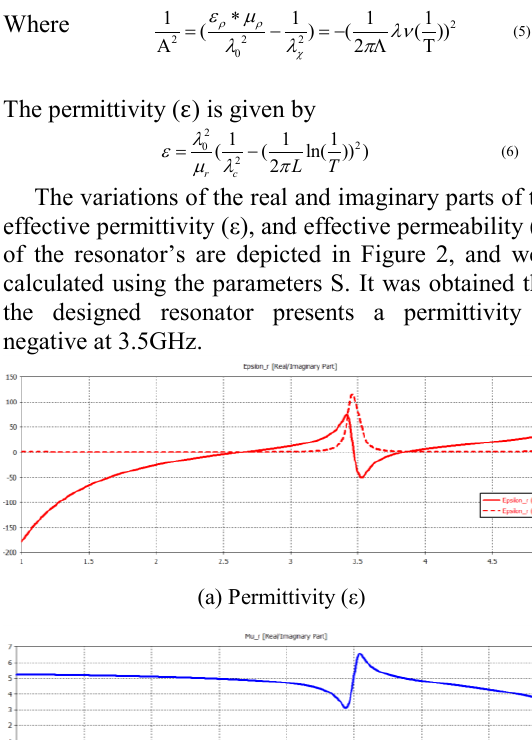
Table 1. The optimized parameters of the CSRR. Parameter